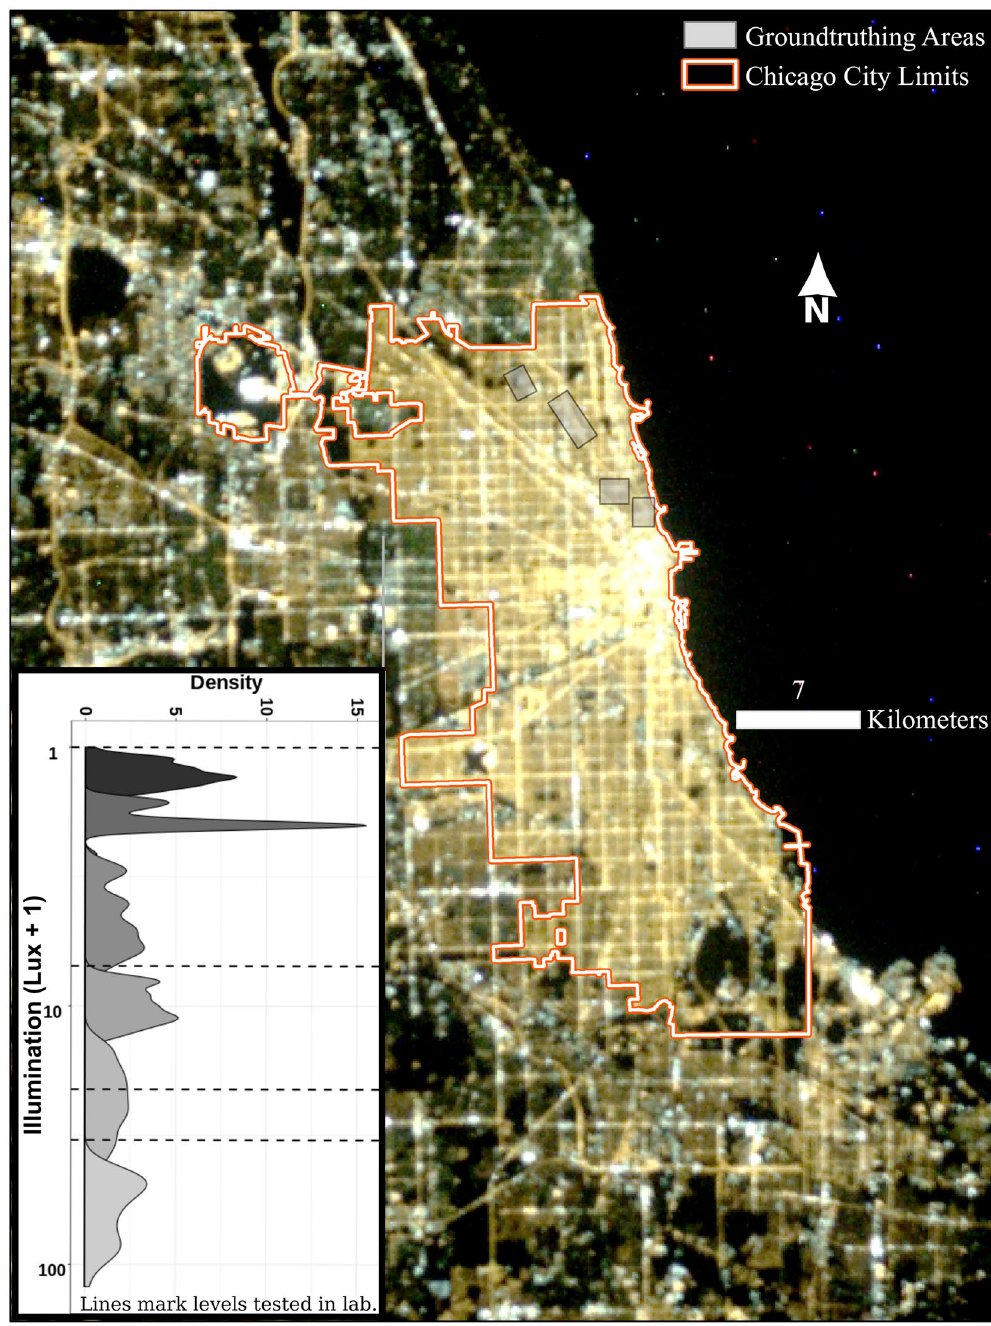
Figure 1. The intensity of light pollution varies across the city of Chicago. A 2013 nighttime image from the International Space Station (ISS) shows concentrations of nighttime lights near the central business district and along major roadways, as well as in large parking lots. The inset shows the distribution of clusters of control points’ illumination, sampled in areas of moderate and diverse light intensity shown on the satellite image, identified using finite mixture models. Laboratory illumination levels were chosen to be broadly representative of the most common varying light levels measured in the control